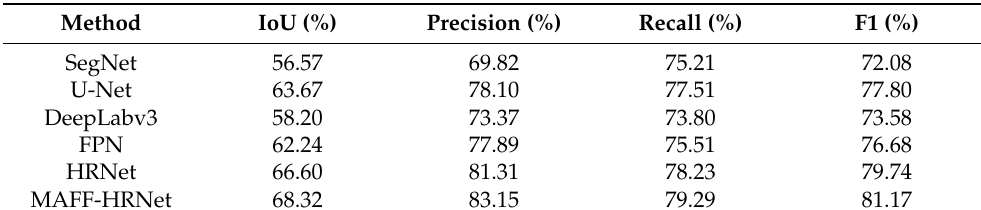
Table 1. Evaluation results on the Massachusetts Buildings Dataset.